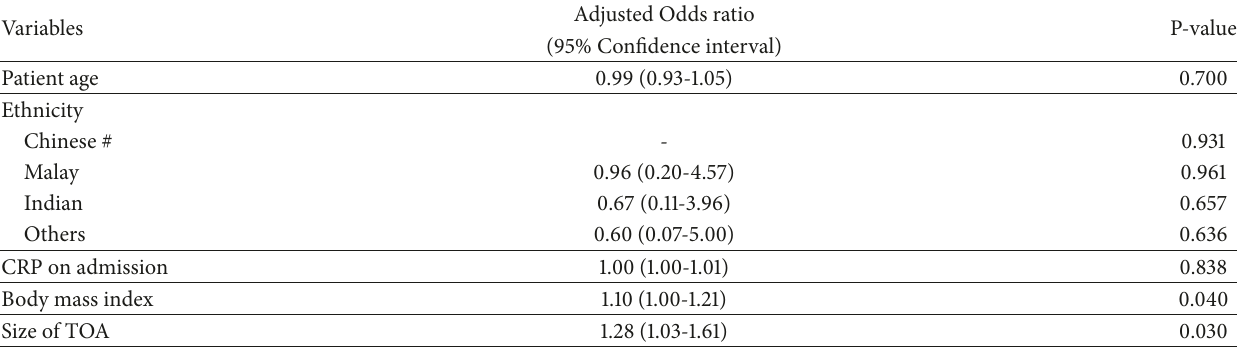
Table 3: Multivariate adjusted odds ratios of patients who underwent medical and surgical treatment. Each factor in the model is adjusted for all other factors.